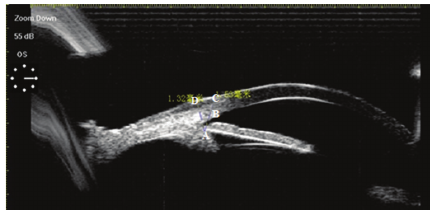
Figure 1: Location of sulcus by UBM before surgery (A = sulcus, B = scleral spur, C = back boundary of corneal limbus, and D = the projecting position of sulcus on the scleral surface).